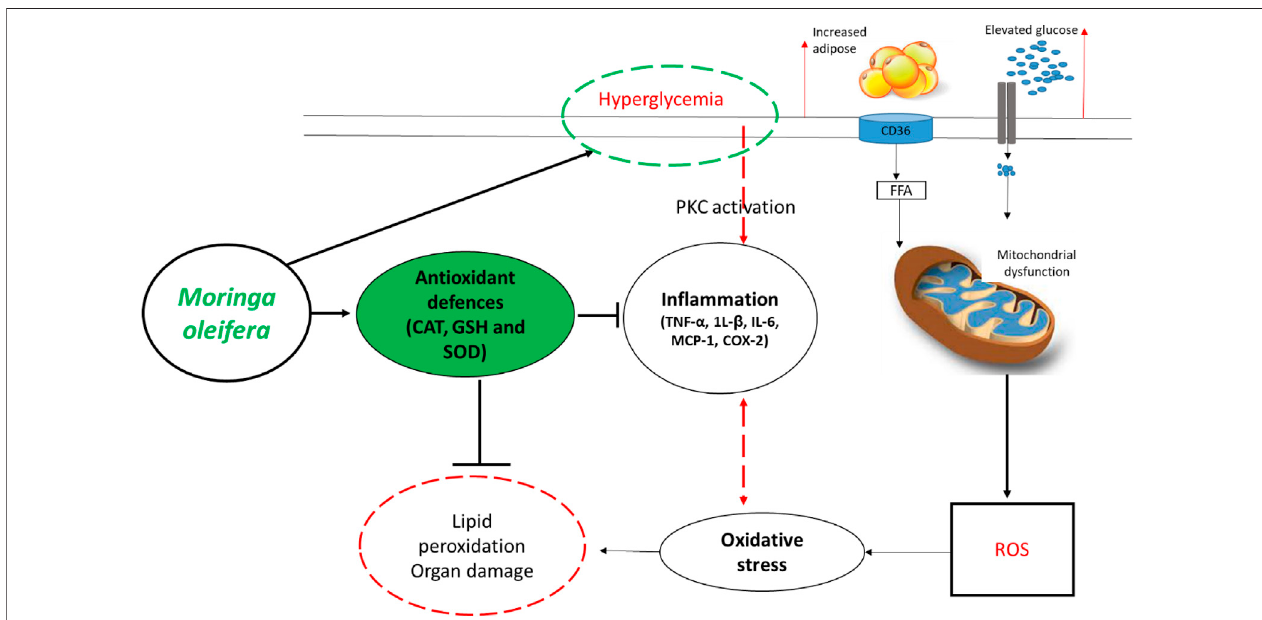
FIGURE 3 | An overview of therapeutic mechanisms associated with the ameliorative effects of Moringa oleifera extracts in preclinical (animal) models of diabetes. Brie fl y, overwhelming evidence supports the bene fi cial effects of this plant in enhancing intracellular antioxidants such as catalase (CAT), glutathione (GSH) and superoxide dismutase (SOD) to block the detrimental effects reactive oxygen species (ROS), lipid peroxidation and organ damage. This is in part by also improving glucose control (hyperglycemia) and reducing prominent pro-in fl ammatory markers like tumor necrosis factor-alpha (TNF- α ), interleukin (1L)- β , IL-6, monocyte chemoattractantprotein-1(MCP-1)andCOX-2-cyclooxygenase-2(COX-2).Abbreviations:CD36-clusterofdifferentiation36;FFA-freefattyacid;PKC-proteinkinaseC. Indicators: red lines-detrimental effects, bold lines/green lines-protective effects of Moringa oleifera extracts.